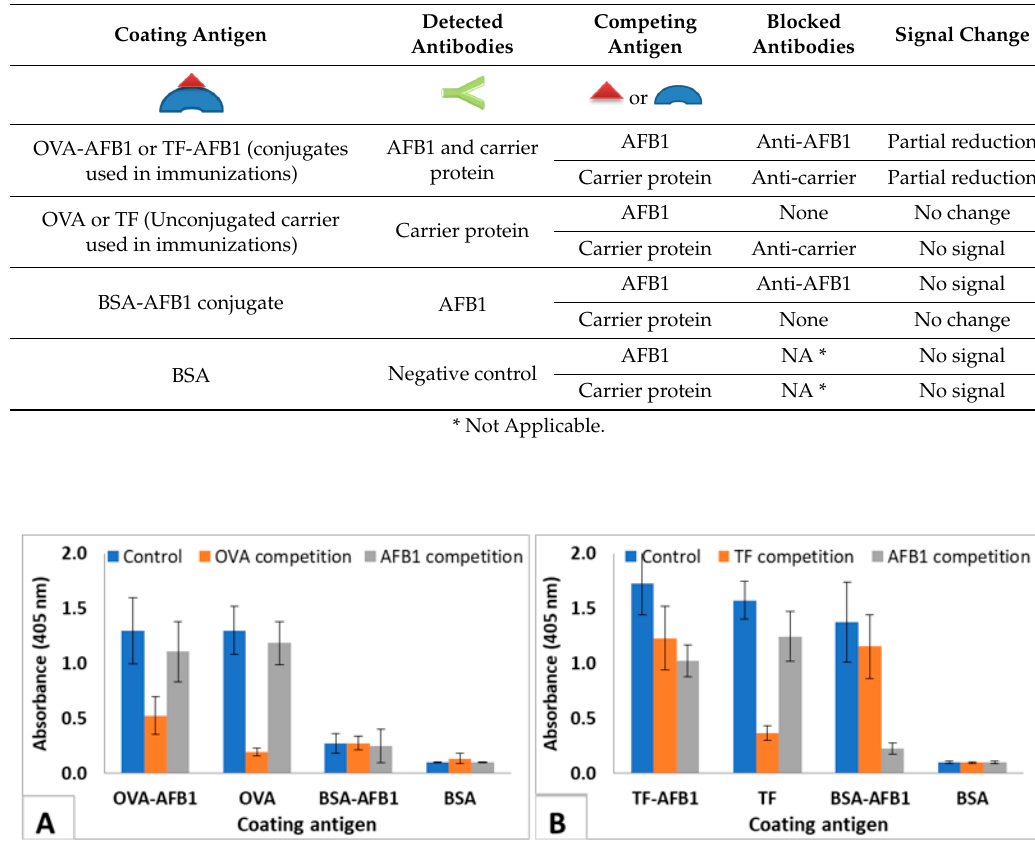
Table 1. Interpretation of IC-ELISA results.